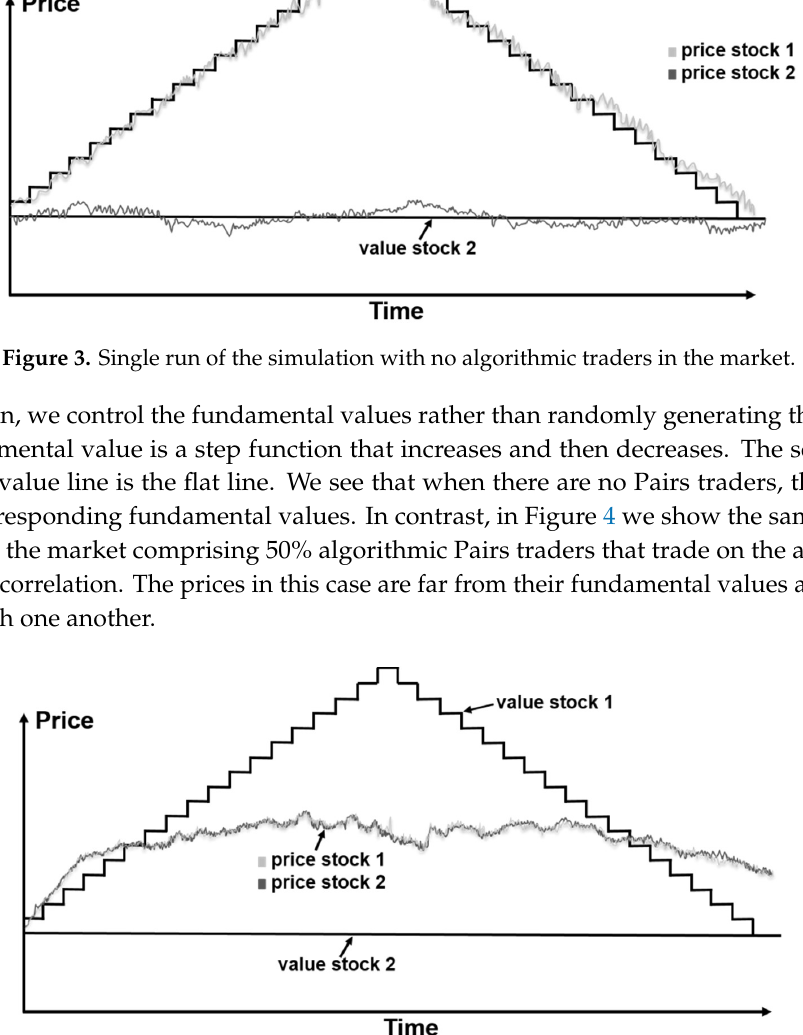
Figure 4. Single run of the simulation with 50% algorithmic pairs traders in the market.